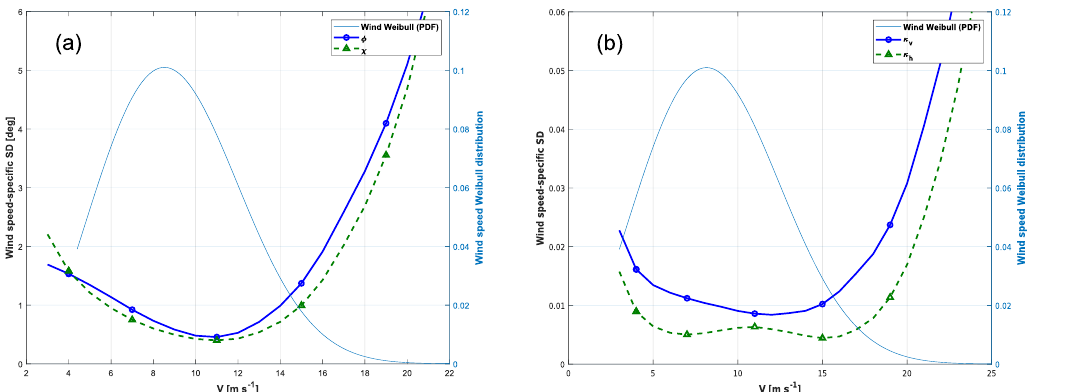
Figure 18. Wind-speed-specific standard deviation of the observation error for angles φ and χ (a) and for shears κ v and κ h (b) . The wind Weibull distribution is characterized by shape and scale parameters equal to 2.5 and 10, respectively.